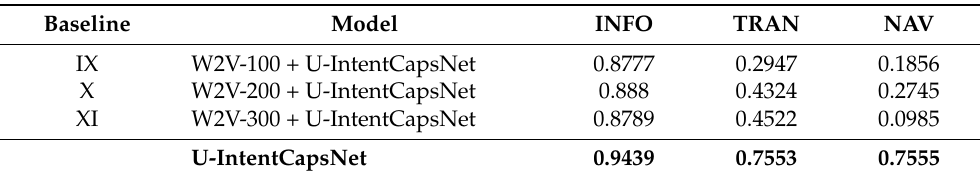
Table 12. F1 scores of intent detection for baseline models with pre-trained W2V embeddings and the proposed U-IntentCapsNet model.